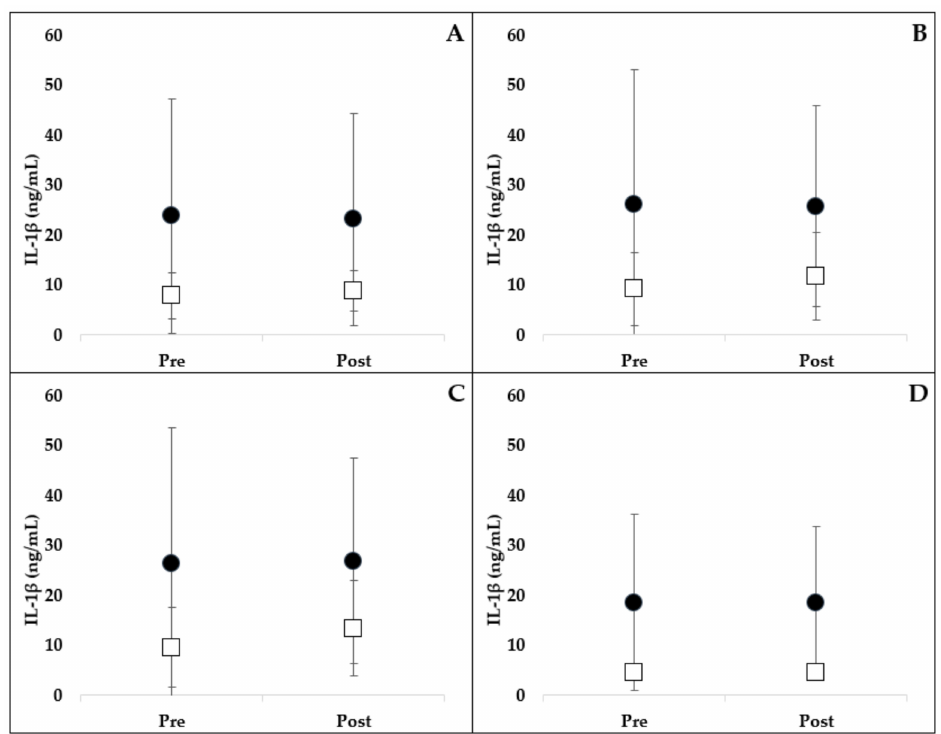
Figure 2. Leukocyte production of IL-1 β following stimulation with LPS ( A ), LTA ( B ), PG ( C ) and control PBS ( D ). Pre- and post- 3-week oral administration of placebo (open square) or resveratrol (closed circle) supplement are represented. There was no significant di ff erence in IL-1 β production between treatment groups over time (mean ± SD). LPS, lipopolysaccharide; LTA, lipoteichoic acid; PBS, phosphate-bu ff ered saline; PG,